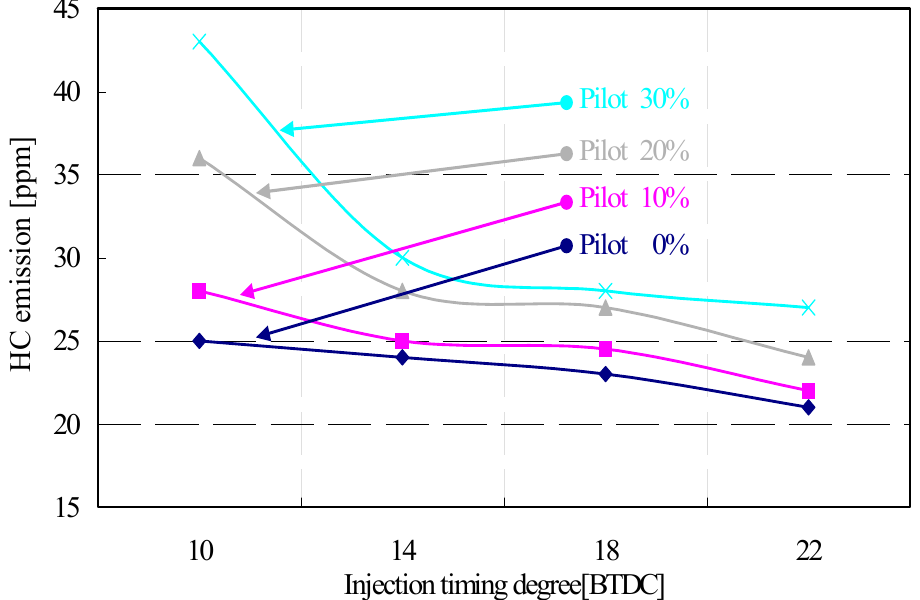
Figure 12. HC emission characteristics of DME engines with the pilot injection duration rate as a function of injection timing.